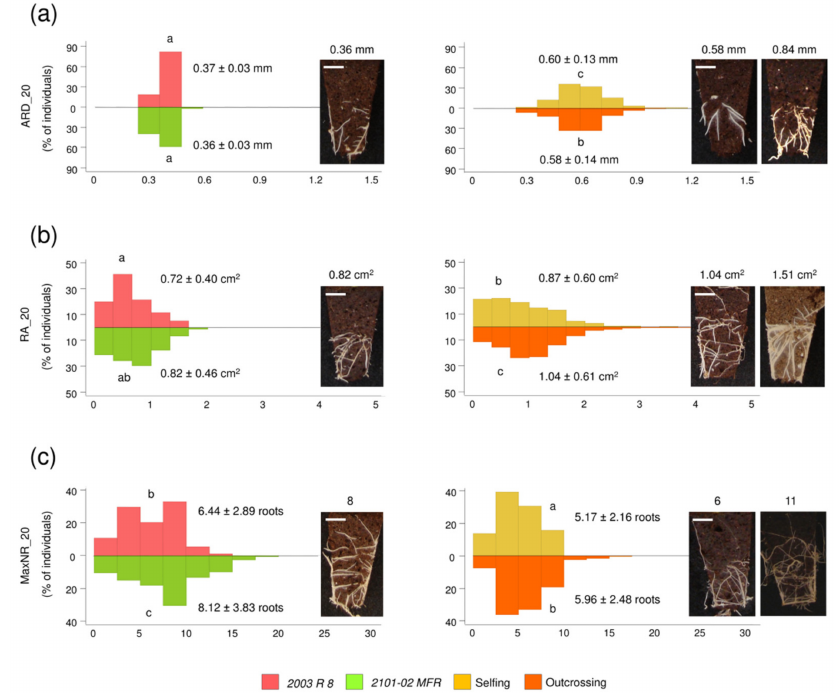
Figure 3. Examples of transgressive segregation observed in principal component analysis (PCA) relevant traits at 20 dap. ( a ) Average root width (ARD_20), ( b ) root area (RA_20), and ( c ) maximum number of roots (MaxNR_20) in the F 1 population grouped by selfing (yellow) and outcrossing (orange) lines compared with 2003 R 8 (red) and 2101-02 MFR (green) parental lines. Representative images of the average values of the best-rooting parental line 2101-02 MFR (left) and average (medium) and maximum (right) values in the outcrossing subpopulation are shown. Letters indicate significant di ff erences between the population groups (LSD; p -value < 0.05). Scale bar: 10